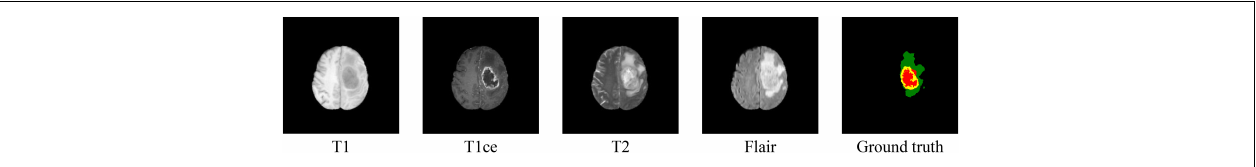
FIGURE 1 | Samples of MRI images in four modalities and their ground truth. In the ground truth image, red, green, and yellow stand for tumor core (TC), whole tumor (WT), and enhance tumor (ET),